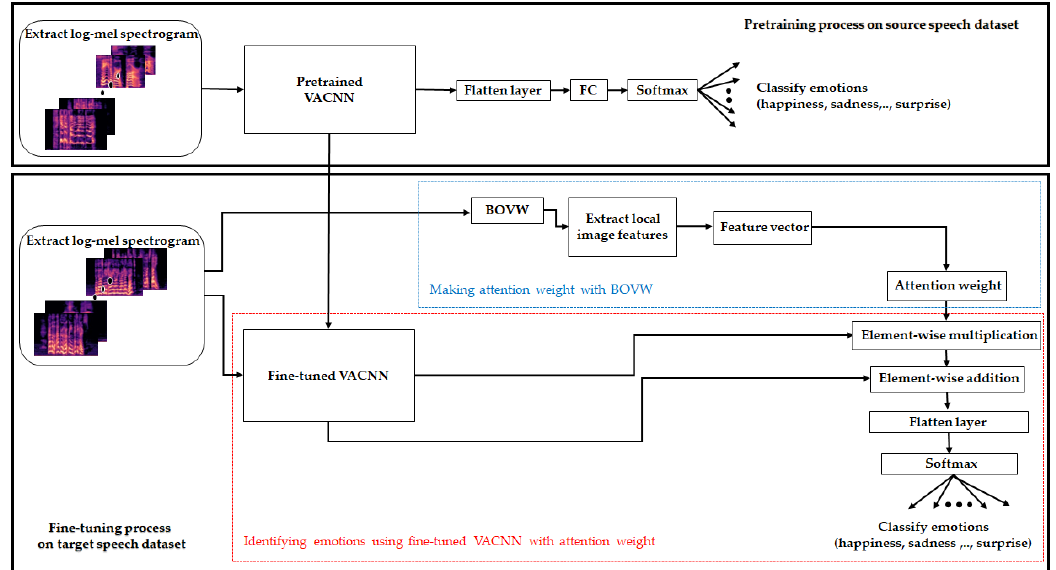
Figure 1. Overall architecture of our pretraining and fine-tuning models for SER.